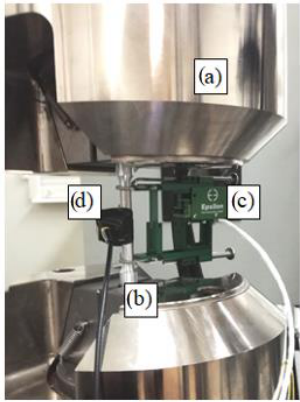
Figure 4. View of the specimen fixed to the tensile testing machine grips: ( a ) tensile testing machine grips, ( b ) specimen, ( c ) extensometer, ( d ) AE sensor.